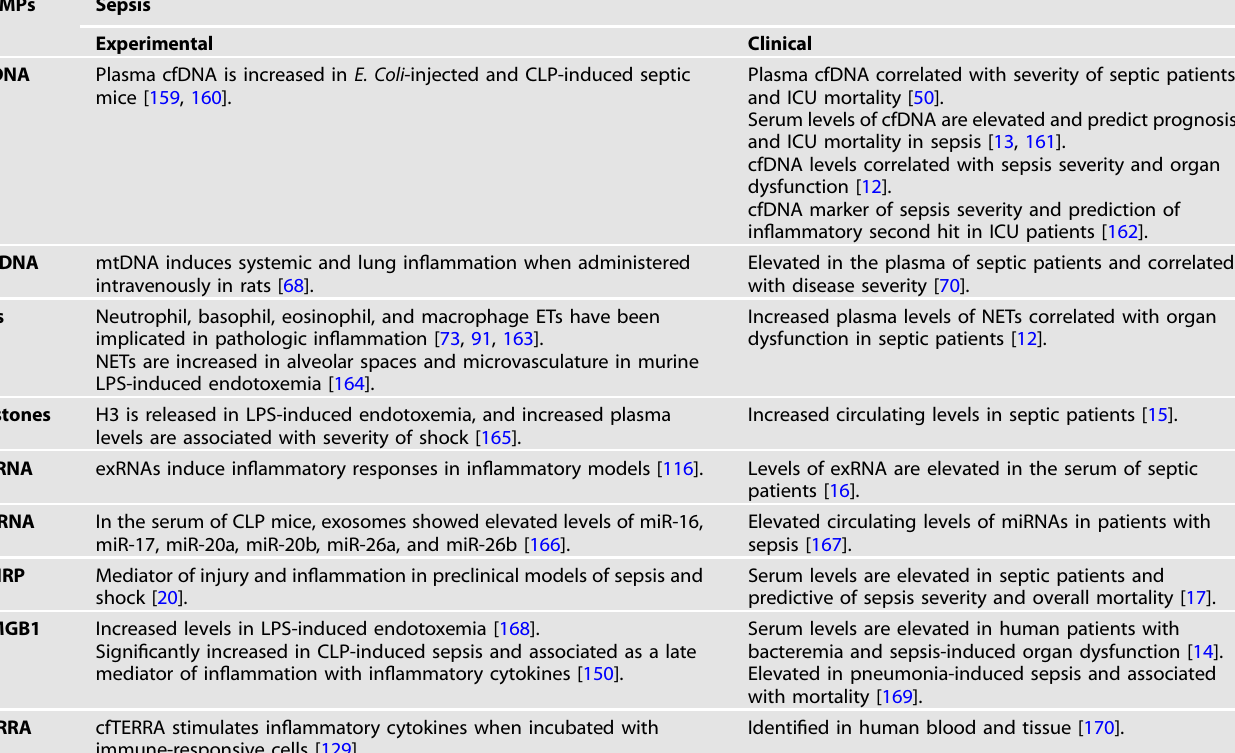
and ICU mortality [50].